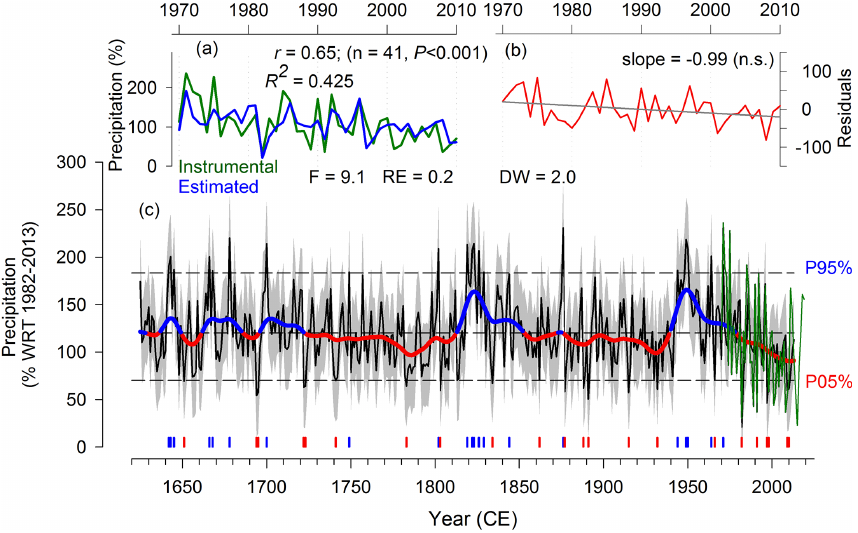
Figure 3. Precipitation variations in the northern sector of the Altiplano during the last 4 centuries. (a) Observed (instrumental; green line) and estimated (tree ring; blue line) variations in late-spring–mid-summer precipitation (November–January) in the northern part of the Altiplano (precipitation anomalies are expressed in percentages with respect to the calibration period 1970–2010). Calibration and verification statistics: explained variance ( R 2 ) during the calibration period, Pearson’s correlation coefficient ( r ) between observed and reconstructed values, regression F value, and reduction of error (RE). (b) The residuals of the regression (red line) with the slope of the trend (black line). The Durbin–Watson (DW) statistic and the trend slope are indicated. (c) Tree-ring-based reconstruction of late-spring–summer precipitation in the northern Altiplano region for the period 1625–2013 (precipitation anomalies expressed in percentages (%) with respect to the average instrumental precipitation for the common period 1982–2013). To emphasize the low-frequency variations, a 35-year cubic smoothing spline reducing 50% of the reconstruction variance is shown. Values above (below) the reconstructed mean for the period 1625–2013 are indicated with blue (red) lines. The gray band represents the RMSE. Vertical red (blue) bars in the bottom of the panel indicate the extreme dry/pluvial events calculated for the 5th (95th) percentile